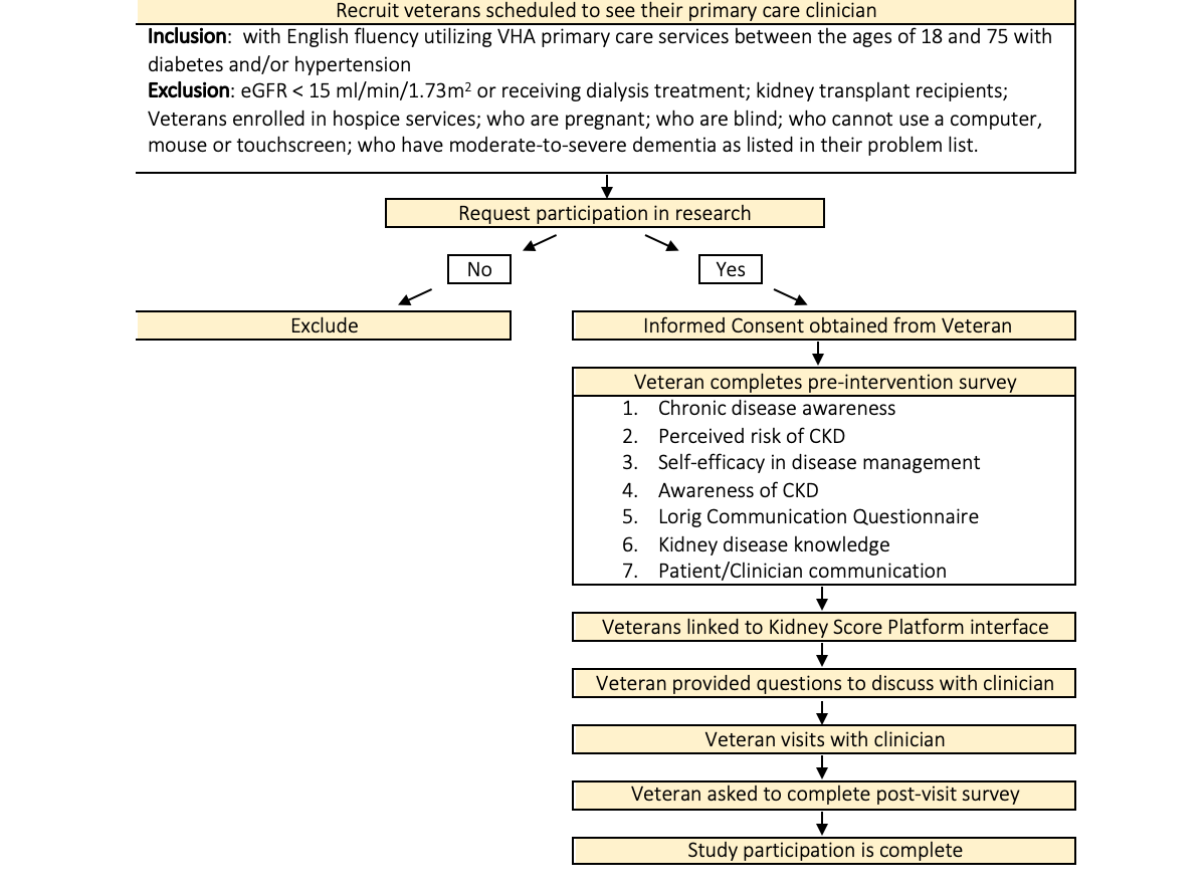
Figure 3. Process flow for Kidney Score study. CKD: Chronic Kidney Disease; eGFR: estimated glomerular filtration rate; VHA: Veteran's Health